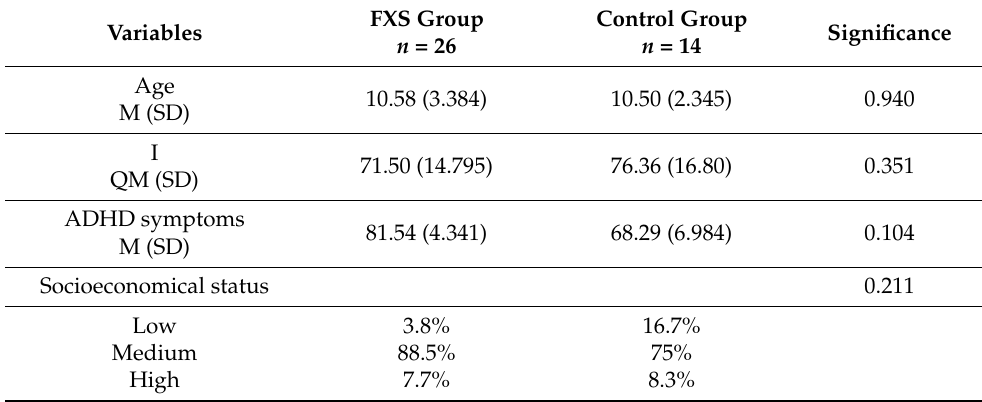
Table 1. Descriptive measures and distribution of age, IQ, ADHD Symptoms, and socioeconomical